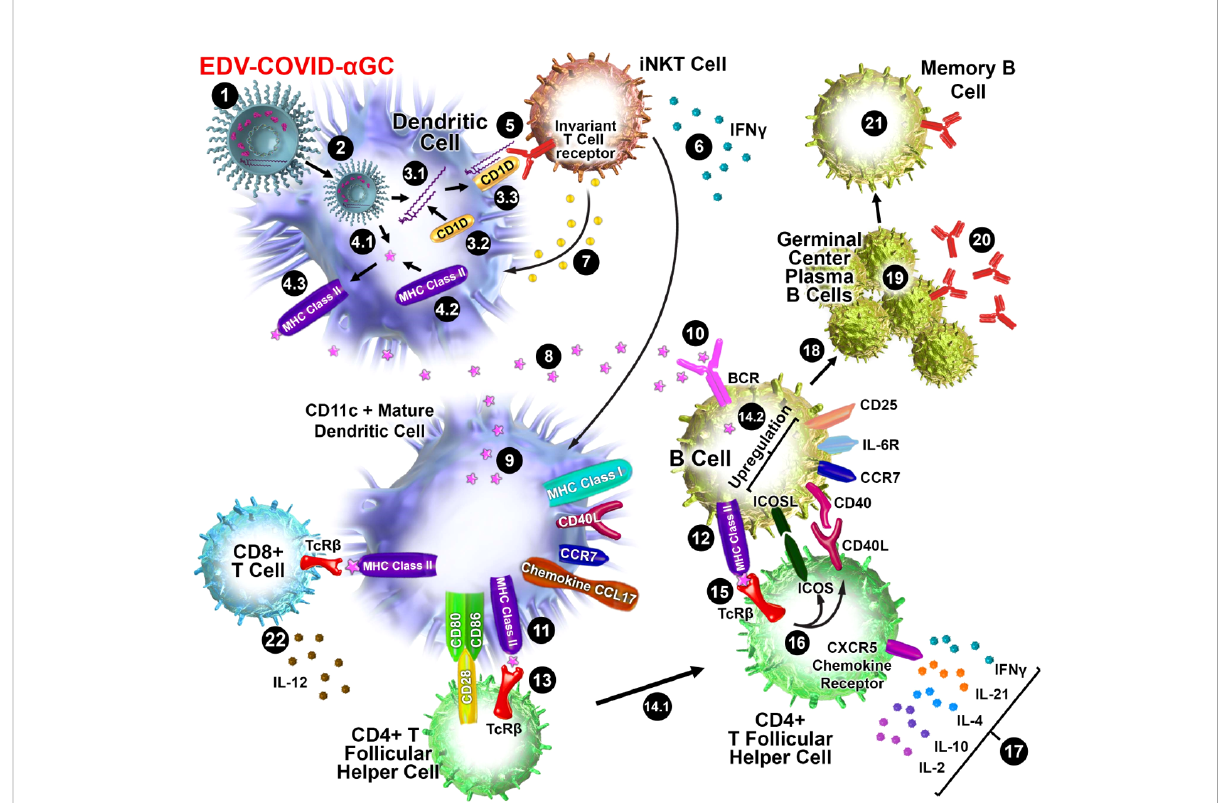
FIGURE 5 Schematic diagram of iNKT-licensed dendritic cell activation (1). EDV-COVID- a GC injected i.m. in mice (2), phagocytosed by dendritic cells (DC), degraded in lysosomes, (3.1) a GC released from EDVs, (3.2) CD1d binds to a GC, (3.3) CD1d: a GC complex displayed on DC cell surface, (4.1) spike polypeptides also released from EDVs, (4.2) MHC Class II binds to the S-peptides, (4.3) display them on same DC cell surface (5). iNKT semi-invariant T cell receptor binds to CD1d/ a GC complex (6), rapidly secretes IFN g which triggers upregulation of CD40 ligand in DCs